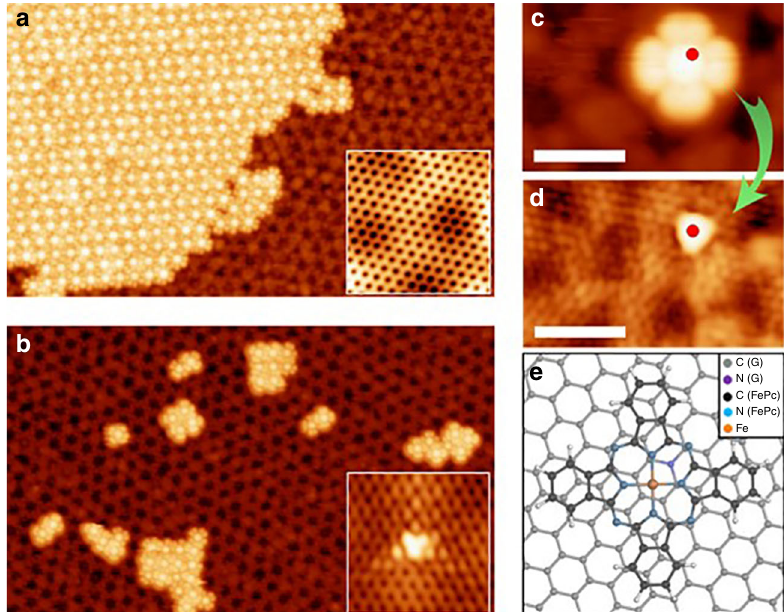
Fig. 1 FePc adsorption on pristine and N-doped graphene at room temperature. 50 nm × 30 nm scanning tunneling microscopy (STM) images for FePc molecules on a pristine and b doped graphene (V b = ‒ 2.0 V; I t = 10 pA). The insets show high-resolution STM images of graphene and a N-dopant. c FePc molecule adsorbed on N-doped graphene before the manipulation event (V b = ‒ 2.0 V, I t = 10 pA). d The N-dopant revealed after controlled lateral manipulation of the FePc (V b = – 0.05 V, I t = 10 pA). The red dot in c and d denotes the position of the N atom in the graphene lattice. The scale bars correspond to 2 nm. e Optimized model structure of FePc on N-doped